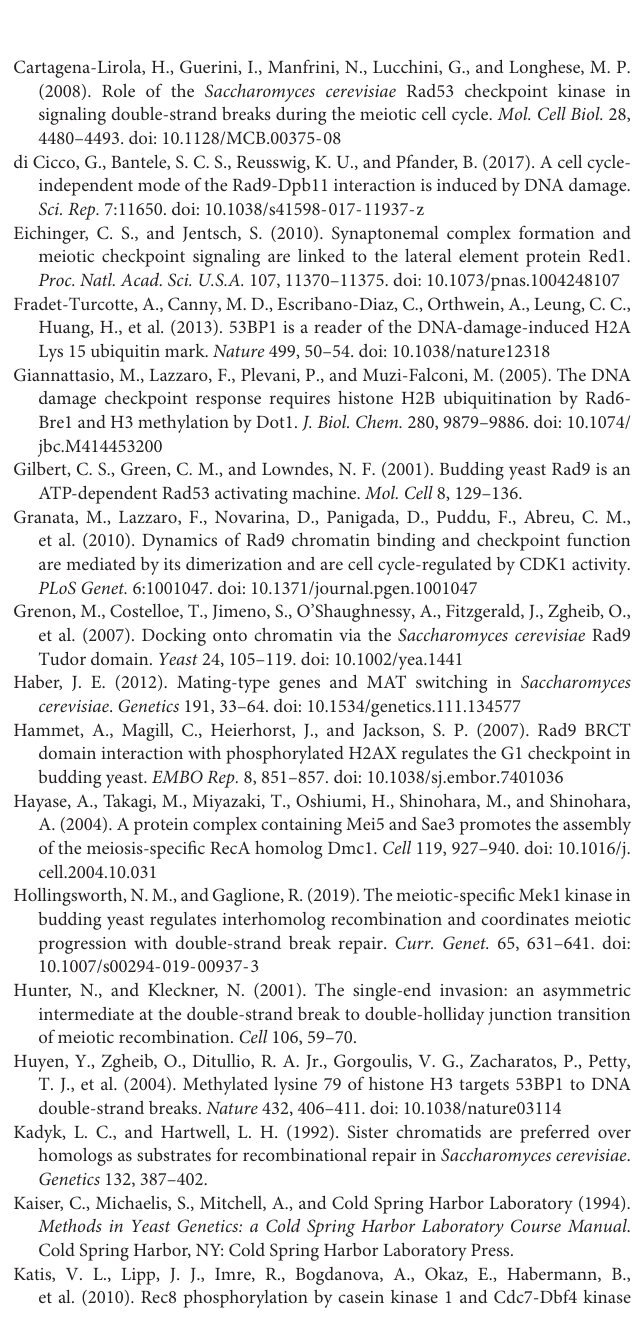
cells were loaded for anti-HA or anti-Flag/tubulin Western blot, respectively. Dilutions were prepared accordingly. Supplementary Figure 5 | The representative images of immunostaining of nuclear spreads prepared from dmc1 RAD53 DDC2-RAD9 (USY580/591) at 6 h and dmc1 rad53-KD DDC2-RAD9 (USY582/623) at 4.5 h in meiosis are shown with anti-HA and anti-Rad51. DNA images stained with DAPI are also presented. Bar equals 5 µ m. Supplementary Figure 6 | (A) DNA contents of wild type (USY543/544) and DDC2-RAD9 (USY544/671) strains were examined by FACS analysis. The representative profiles were shown. (B) The percentage of nuclei of the indicated strains that had more than five Rad51 or Dmc1 foci was plotted each time